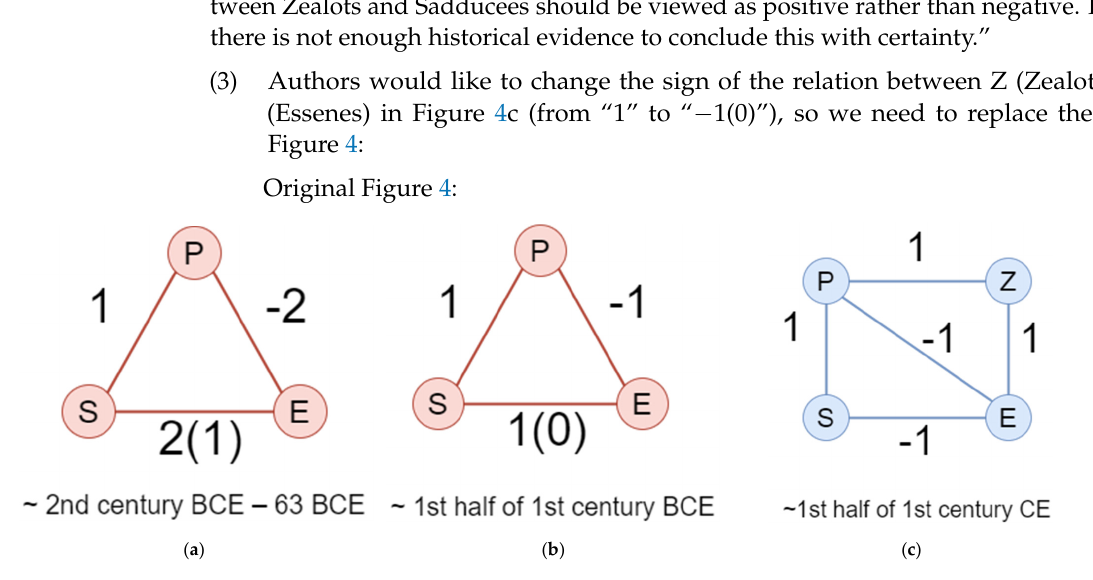
Figure 4. Visualization of the relations between Judaean sects during the period 2nd century BCE–74 CE. The vertices are denoted S (Sadducees), P (Pharisees), E (Essenes), and Z (Zealots). The panels illustrate the relations during different periods: ( a ) the period from the 2nd century BCE to the advent of the Romans in Judea in 63 BCE; ( b ) the first half of the 1st century BCE; ( c ) the period from 6 BCE until 74 CE.